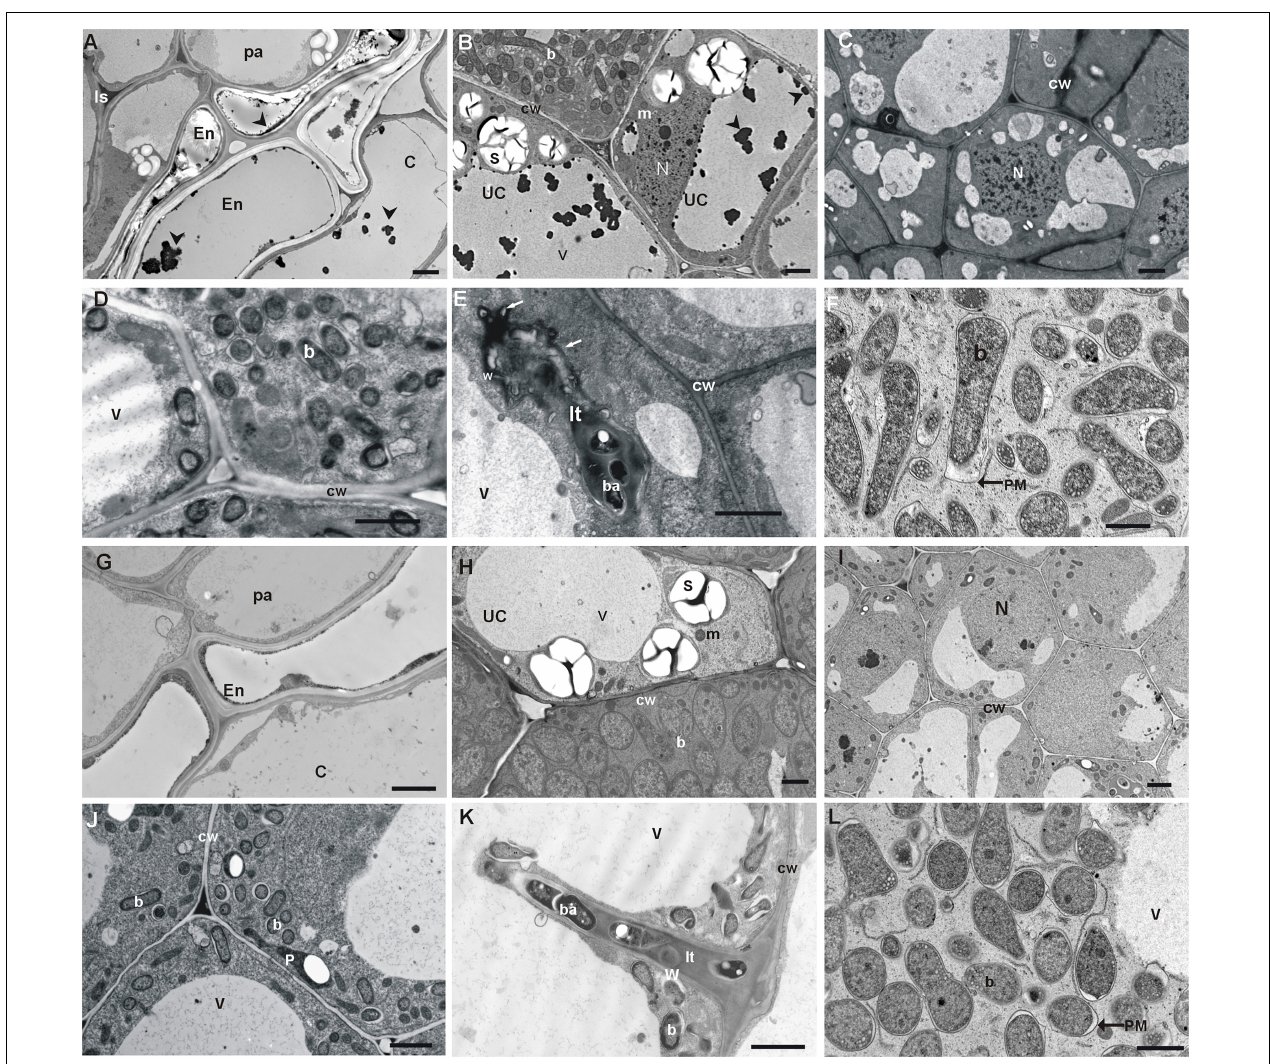
FIGURE 4 | TEM micrographs of waste heap origin T. repens nodules (A–F) and non-polluted reference ones (G–L) . (A) Nodule cortex tissues: thick-walled parenchyma (pa) cells with dark inclusion in intercellular spaces (Is), and double-layer nodule endodermis (En), and cortex cells with dark precipitates (an arrowhead) in their vacuoles. (B) Visible dark inclusions (an arrowhead) in central and small vacuoles of uninfected cells (uc). (C,D) Abnormal thick-walled cells in the thread penetration zone and the early symbiosis zone. (E) Abnormal thick-walled infection thread with lateral bulges (arrows) containing electron-dense depositions of matrix material. (F) Infected cells from the early symbiosis zone and symptoms of early bacteroids degradation (peribacteroidal membrane—PM outgrowths and widening of the peribacteroidal space (an asterisk). (G–L) Control nodules and typical nodule cortex tissues with thin-walled parenchyma (pa) cells; one layer of endodermis and cortex cells without inclusion in vacuoles (G) . (H) Typical vacuoles of bacteroidal tissue devoid of precipitates. (I,J) Typical thin-walled cells of bacteroidal tissues. (K) Thin-walled infection threads and bacteria endocytosis from an un-walled thread tip. (L) Typical bacteroid differentiation and early